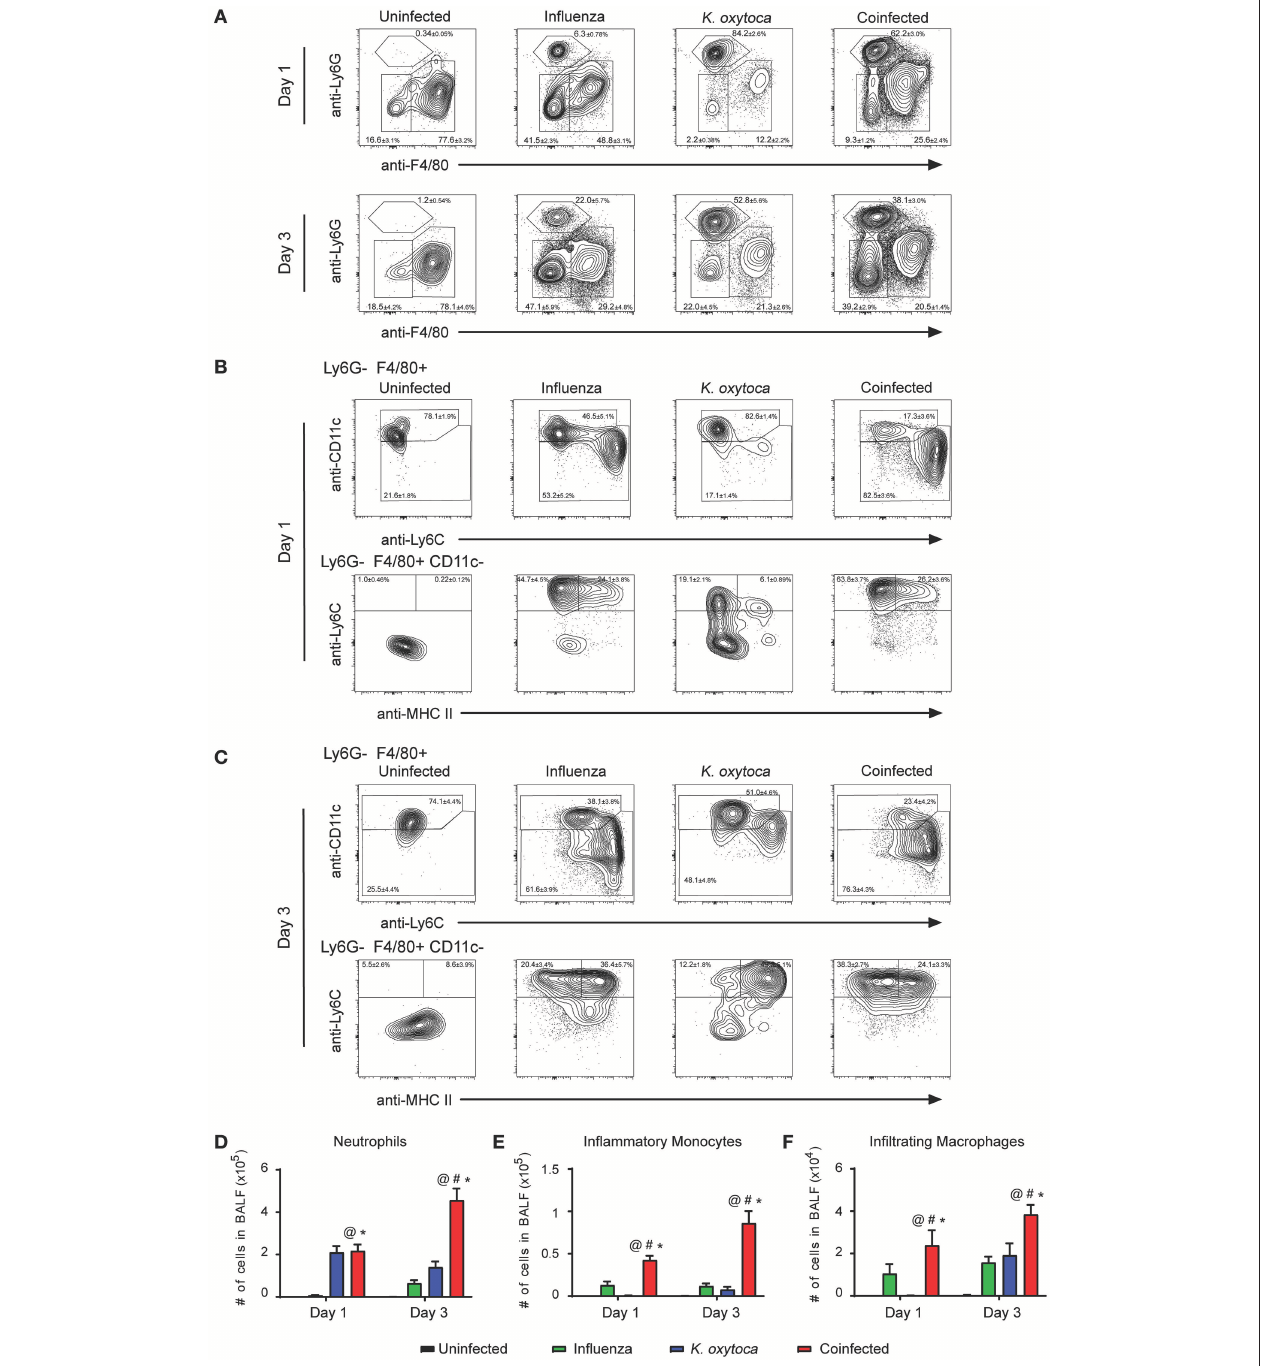
FIGURE 2 | Immune cell infiltrate is increased in the BALF of coinfected mice. Innate immune cell populations were quantified in the BALF of mice on days 1 and 3 post- K. oxytoca infection. We identified neutrophils as Ly6G + F480 − cells and separated the F480 + population according to expression of CD11c with alveolar and repopulating macrophages identified as Ly6G − F480 + CD11c + cells. The CD11c − population was further separated by expression of Ly6C and MHC II with inflammatory monocytes identified as Ly6G − F480 + CD11c − Ly6C + MHC II − cells and infiltrating macrophages identified as Ly6G − F480 + CD11c − Ly6C + MHC II + cells (A–C) . The total number of neutrophils (D) , inflammatory monocytes (E) , and infiltrating macrophages (F) from days 1 and 3 were calculated according to their percentages of the total population and the total number of cells collected in each BALF. @ denotes P ≤ 0.05 between coinfected and uninfected groups. # denotes P ≤ 0.05 between coinfected and influenza groups. * denotes P ≤ 0.05 between coinfected and K. oxytoca groups. Data were analyzed with ANOVA followed by Tukey’s multiple comparison tests. Error bars represent SEM. Data are combined from at least four independent experiments with at least four mice per group.